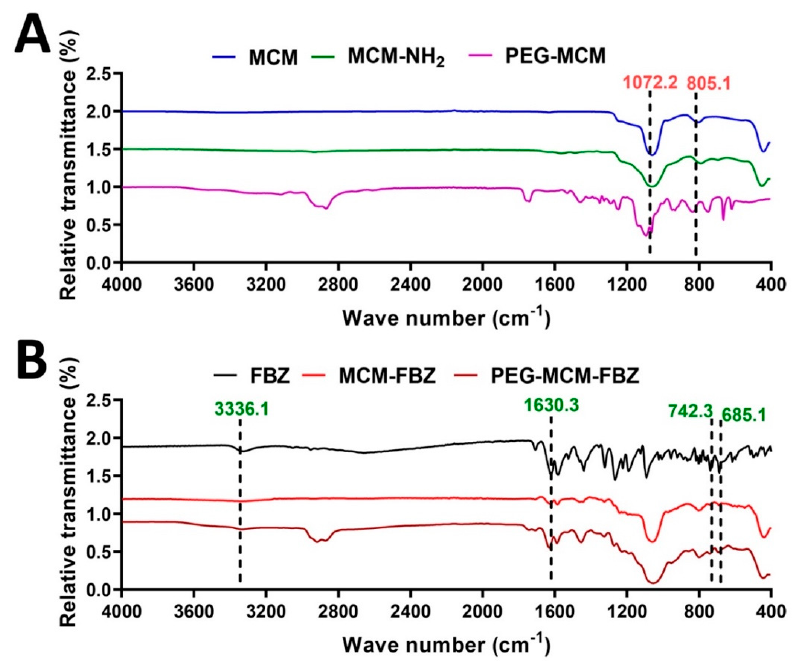
Figure 3. ( A ) FTIR spectrum of MCM, MCM − NH 2 , and PEG − MCM; ( B ) FTIR spectrum of FBZ, MCM − FBZ, and PEG MCM − FBZ